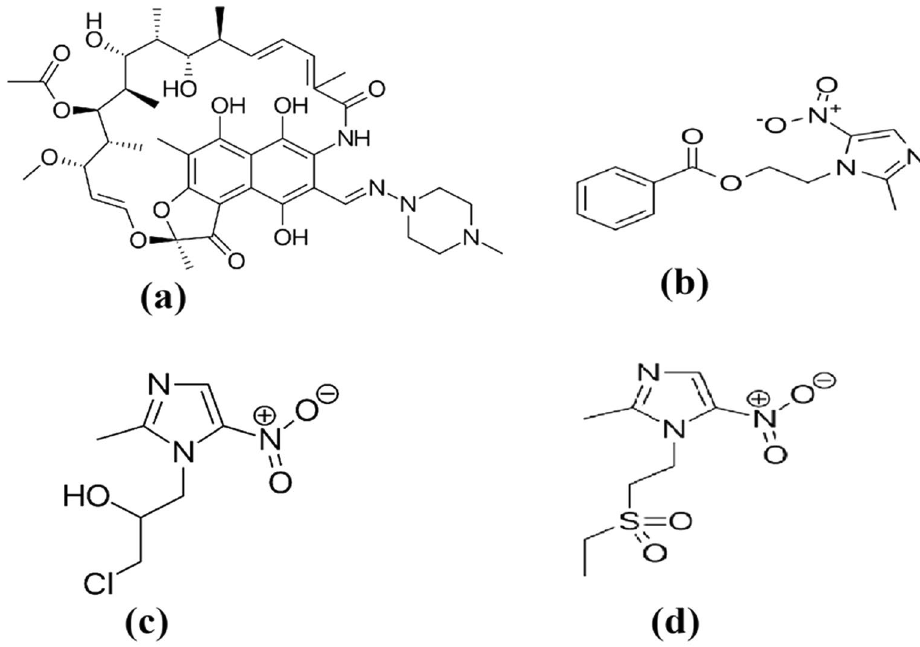
Figure 1. Chemical structure of rifampicin ( a ), metronidazole ( b ), ornidazole ( c ), and tinidazole ( d